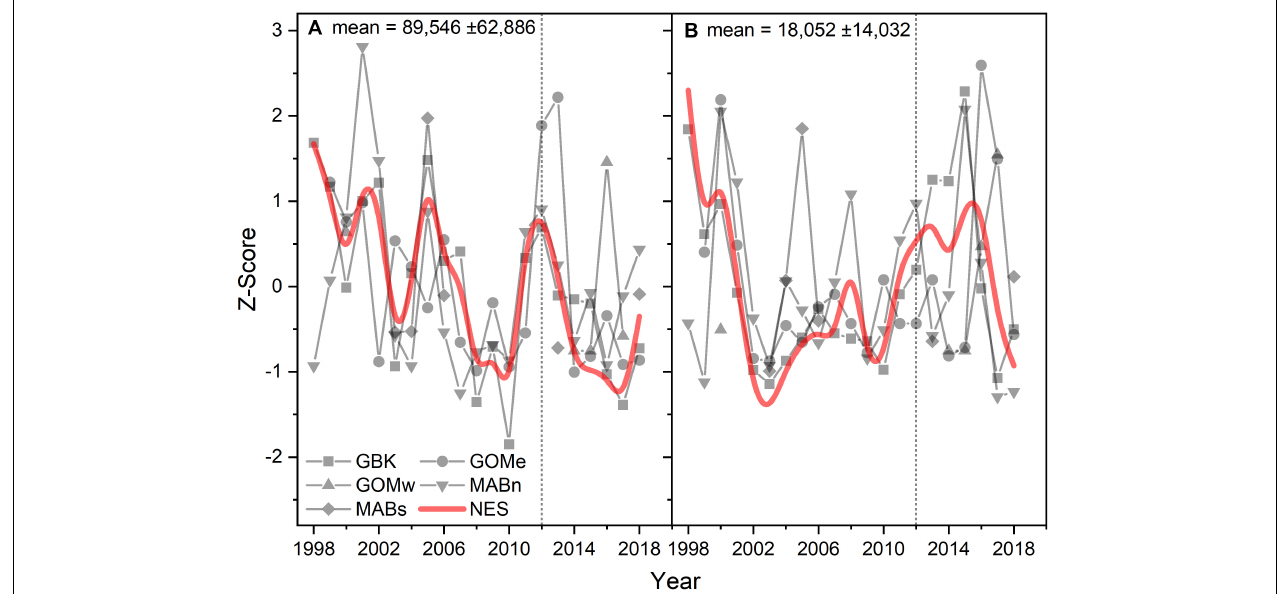
FIGURE 7 | Z-score of the abundance of diatoms (A) and dinoflagellates (B) in a CPR sample unit for the Northeast Shelf (NES) and NES subareas (NES, GBK, GOMe, GOMw, MABn, and MABs). The mean for each abundance shown in the panel title with ± 1 SD; the NES time series is shown as a b-spline; 2012 is highlighted with vertical dotted line.